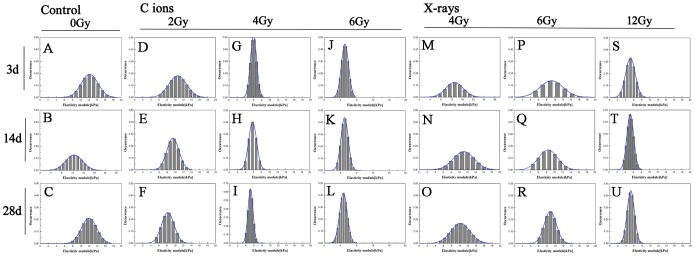
Histograms of erythrocytes elasticity modulus distributions induced by C ions or X-rays exposed for 3, 14 and 28 days.The bar graph (A), (B) and (C) represented control erythrocytes (0 Gy), 3d, 14d and 28d, respectively; the bar graph (D), (E) and (F) represented carbon ions 2 Gy, 3d, 14d and 28d, respectively; the bar graph (G), (H) and (I) represented carbon ions 4 Gy, 3d, 14d and 28d, respectively; the bar graph (J), (K) and (L) represented carbon ions 6 Gy, 3d, 14d and 28d, respectively. But the bar graph (M), (N) and (O) showed X-rays 4 Gy, 3d, 14d and 28d, respectively; the bar graph (P), (Q) and (R) showed X-rays 6 Gy, 3d, 14d and 28d; the bar graph (S), (T) and (U) showed X-rays 12 Gy, 3d, 14d and 28d, respectively.